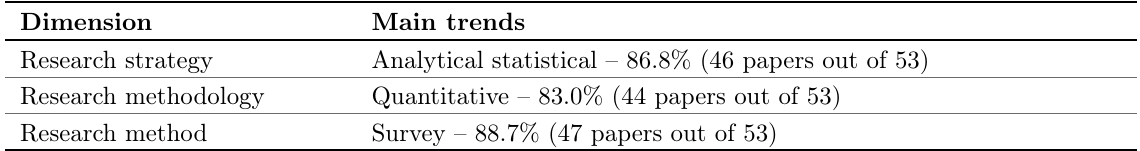
Table 12. Summary of research and methodology aspects (based on Tables 8, 9, and